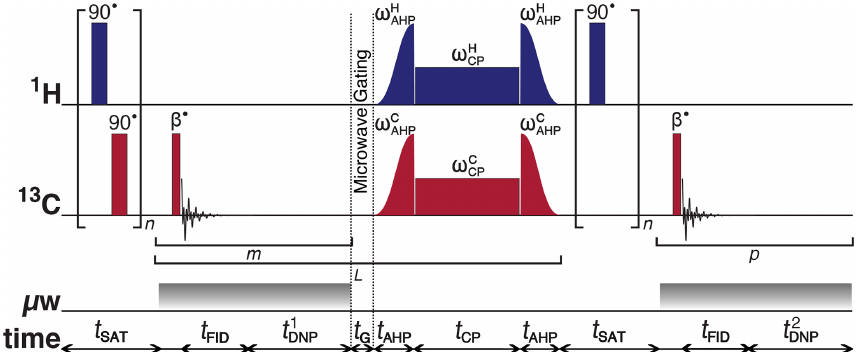
Figure 1. Schematic representation of the rf pulse sequence used to accrue 13 C polarizations and monitor 13 C line shapes as a function of the 1 H polarization. The experiments used the following key parameters chosen to maximize the efficiency of the rf pulse sequence: n = 50; = 30s; L = 8; t = 0.5s; p = 80; and t 2 = 5s. AHP = adiabatic half-passage. AHP sweep width = 100kHz. The β = 3.5 ◦ ; m = 6; t 1 G DNP DNP π/ 2 saturating rf pulses used an empirically optimized 13-step phase cycle to remove residual magnetization at the beginning of each experiment: { 0, π/ 18, 5 π/ 18, π/ 2, 4 π/ 9, 5 π/ 18, 8 π/ 9, π , 10 π/ 9, 13 π/ 9, π/ 18, 5 π/ 3, 35 π/ 18 } . The resonance offset was placed at the most intense peak of the 1 H and 13 C NMR spectra.